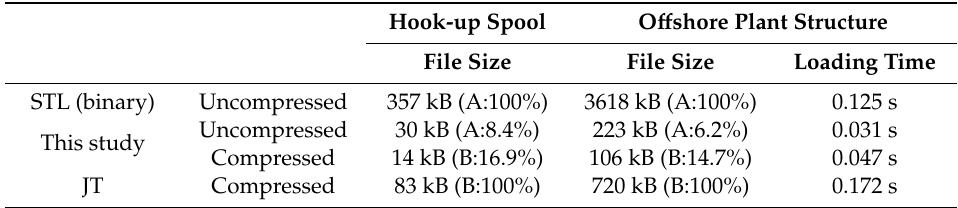
Table 1. Lightweight file sizes and loading times for test cases.